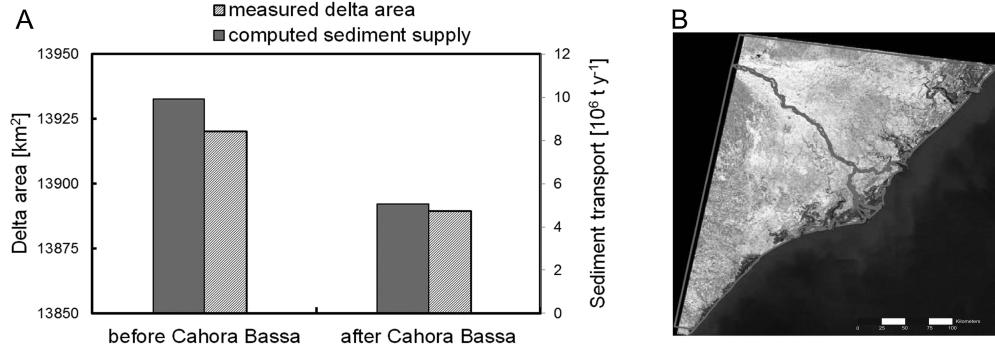
Figure 4. (A) Averaged values of the simulated sediment yield and the measured evolution of the Zambezi Delta from satellite images, before and after the construction of the Cahora Bassa Dam. (B) Satellite image of the Zambezi Delta (USGS database,